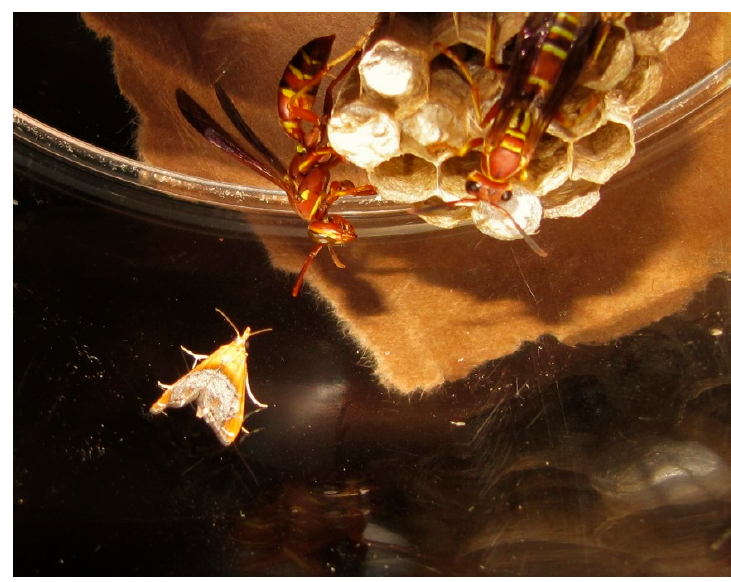
Figure 1. Chalcoela iphitalis approaches a Polistes dorsalis nest with antennae extended.